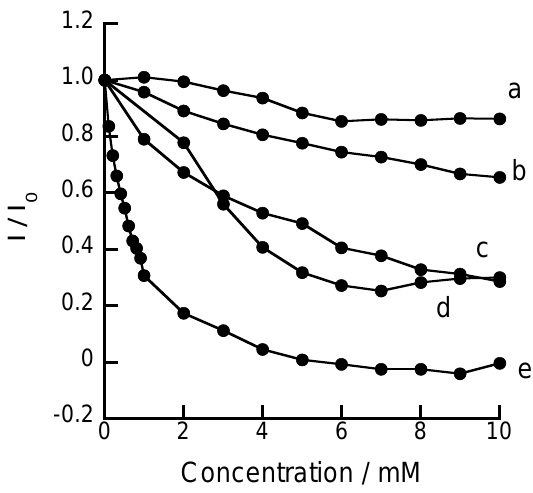
Figure 4. Changes in the reduction peak currents (I/I ) in CV of FcBA as a function 0 of the concentration of phenolic compounds: ( a ) mandelic acid, ( b ) salicylamide, ( c ) 2-hydroxybenzylalcohol, ( d ) salicylic acid, and ( e ) salicylhydroxamic acid. Reprinted with permission from Takahashi et al . [9]. Copyright (2011)